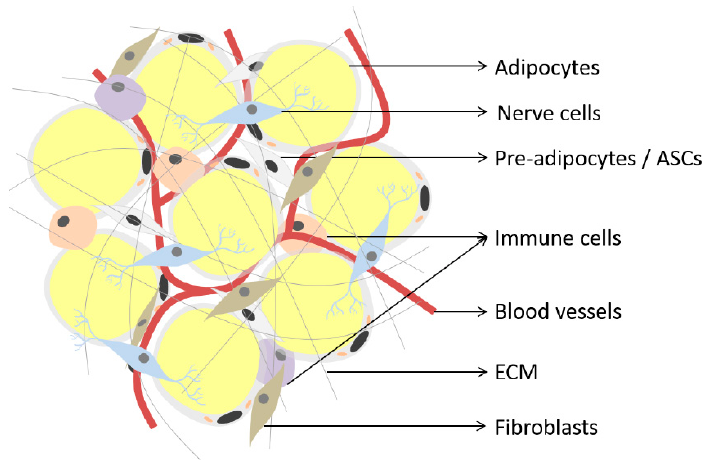
Figure 1. Schematic representation of adipose tissue. Adipose tissue is comprised of adipocytes, preadipocytes, adipose-derived stromal / stem cells (ASCs), immune cells, nerve cells, fibroblasts, blood vessels and extracellular matrix (ECM), among others. Image created by C.d.S.